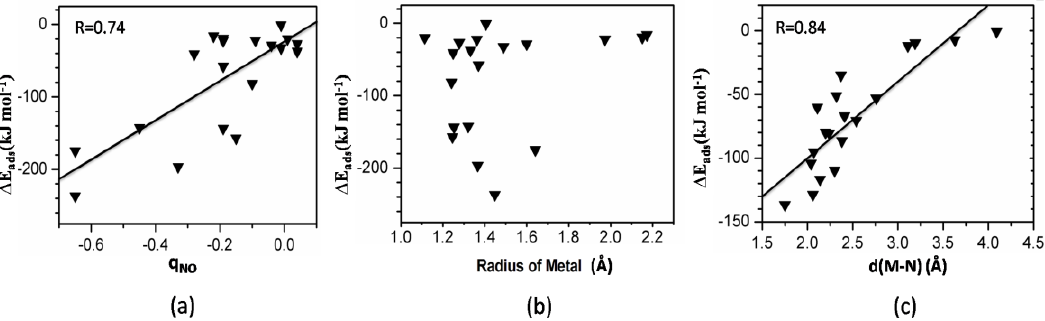
Figure 6. The calculated relationship between the ( a ) NO adsorption energy on M-HKUST-1 and total Bader charge on adsorbed NO, ( b ) NO adsorption energy and metal atomic radius, and ( c ) NH 3 adsorption energy and M-N bond distance.